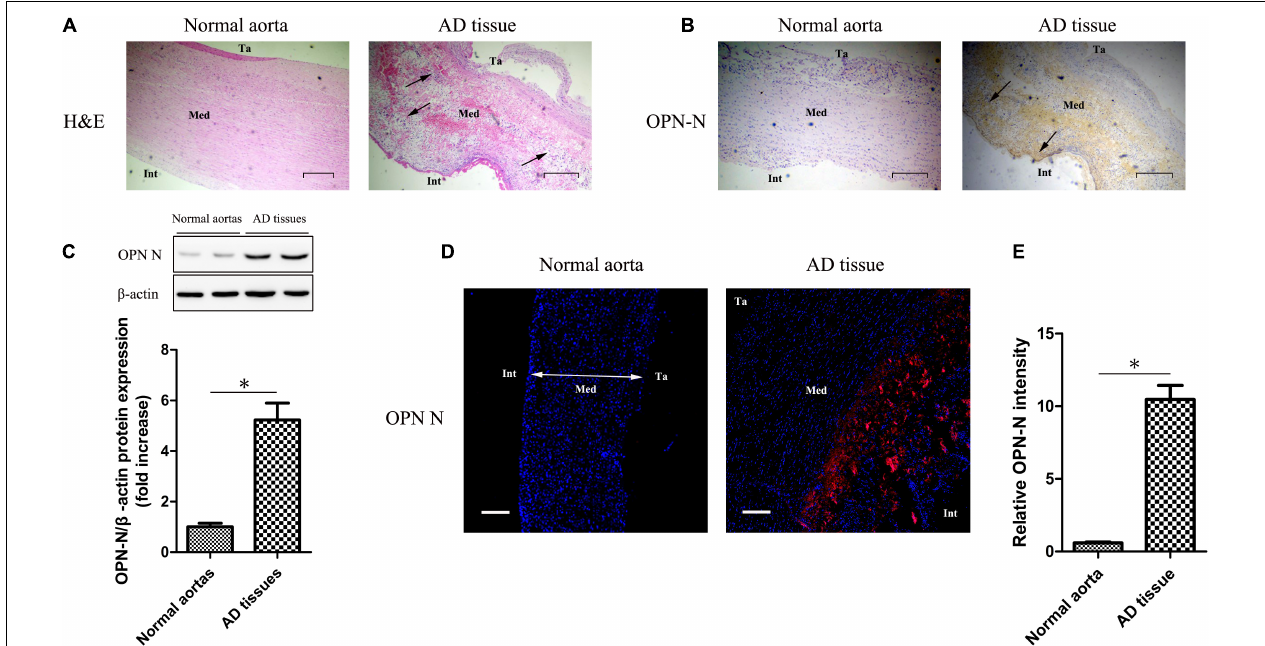
FIGURE 1 | OPN-N expression and histological changes in AD tissues and normal aortas. (A) H&E staining of AD tissue and normal aorta (Scar bar 400 µ m). (B) Immunohistochemistry staining for OPN-N in AD tissue and normal aorta (Scar bar 200 µ m). (C) Western blotting for OPN-N in AD tissues and normal aortas, bar graph showing quantification of OPN-N protein expression. (D,E) Representative immunofluorescence staining for OPN-N in AD tissue and normal aorta (D) and quantification of OPN-N intensity (E) (Scar bar 200 µ m; DAPI staining of nuclei: blue; OPN-N staining: red). β -actin was used as an internal control. Data are expressed as means ± SEM; n = 5 per group. ∗ P < 0.05, unpaired Student’s t test. Abbreviations: AD, aortic dissection; H&E, hematoxylin and eosin; OPN-N, osteopontin N-terminal fragment; Ta, tunica adventitia; Int, intima; and Med,